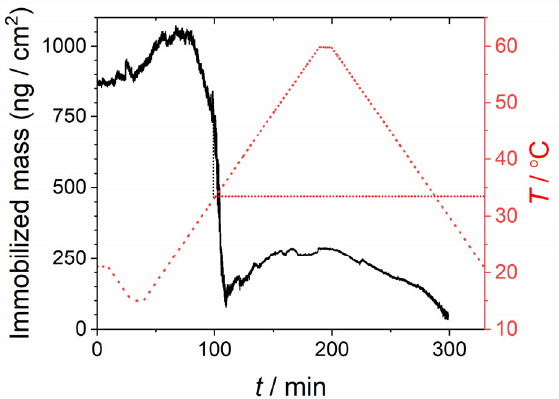
Figure 5. Effect of temperature on the mass of an immobilized film initially consisting of lipodisks at 21 °C. The lipodisks were composed of DSPC:DSPE-PEG2000 with a molar fraction of 80:20.